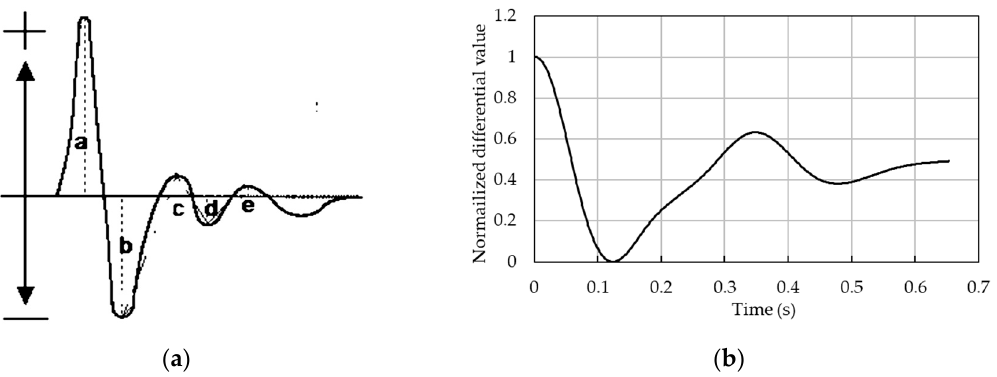
Figure 4. Comparison of acceleration plethysmograph (APG) and silica-FBG waveforms: ( a ) APG waveform and ( b ) silica-FBG sensor waveform.